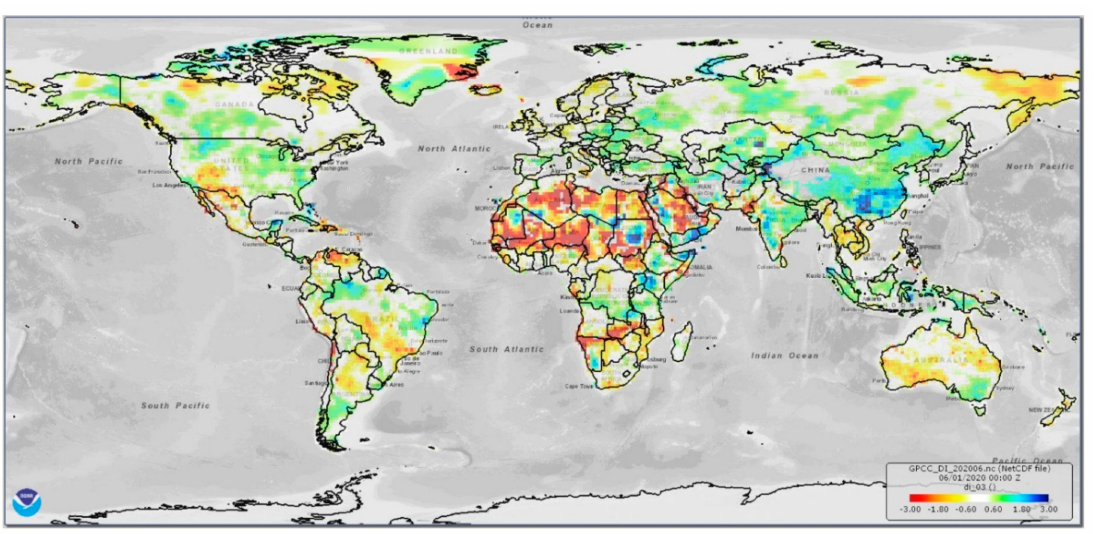
Figure 2. Global drought map, calculated by using the Global Precipitation Climatology Centre (GPCC) Drought Index, indicating the risk of drought occurrence globally, with red zones showing high risk areas and blue zones indicating low risk areas. (Source: National Integrated Drought Information System